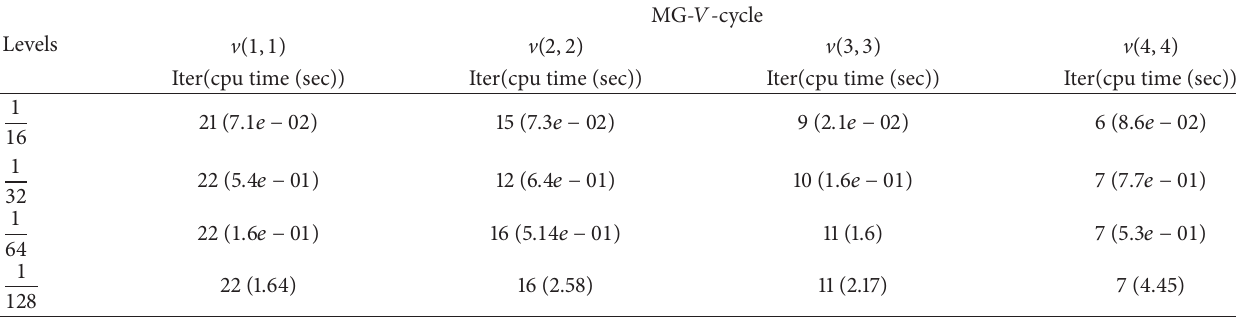
Table 2: Number of iterations and CPU time for Braess-Sarazin ( 2 diag( 𝐴 ), V -cycle( 1, 1 )) multigrid 𝑉 -cycle at different levels of refinement, tolerance = 10 −6 .